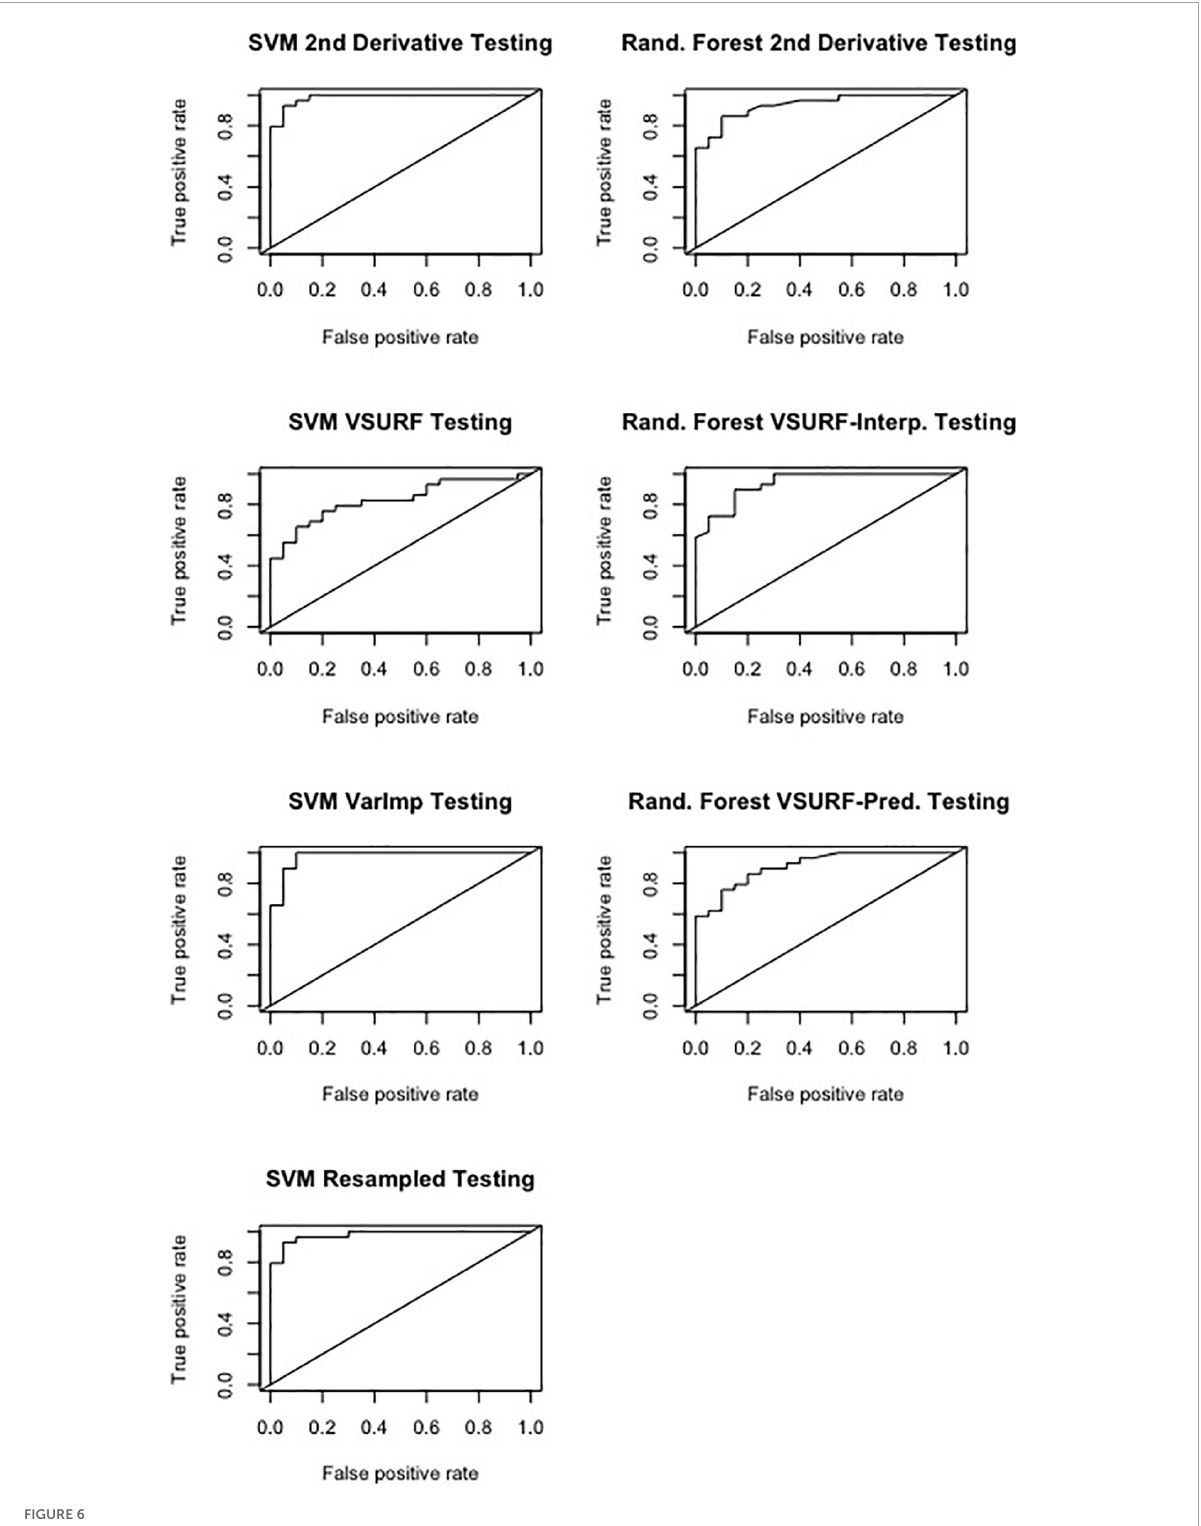
FIGURE6 Receiver operating characteristic (ROC) curves derived from the testing of the support vector machine (SVM) (left) and random forest (right) , showing the classification accuracy of spectra from pre-symptomatic samples from only the Kiwanis site and local-naïve samples for the September dataset. The diagonal line represents perfect chance